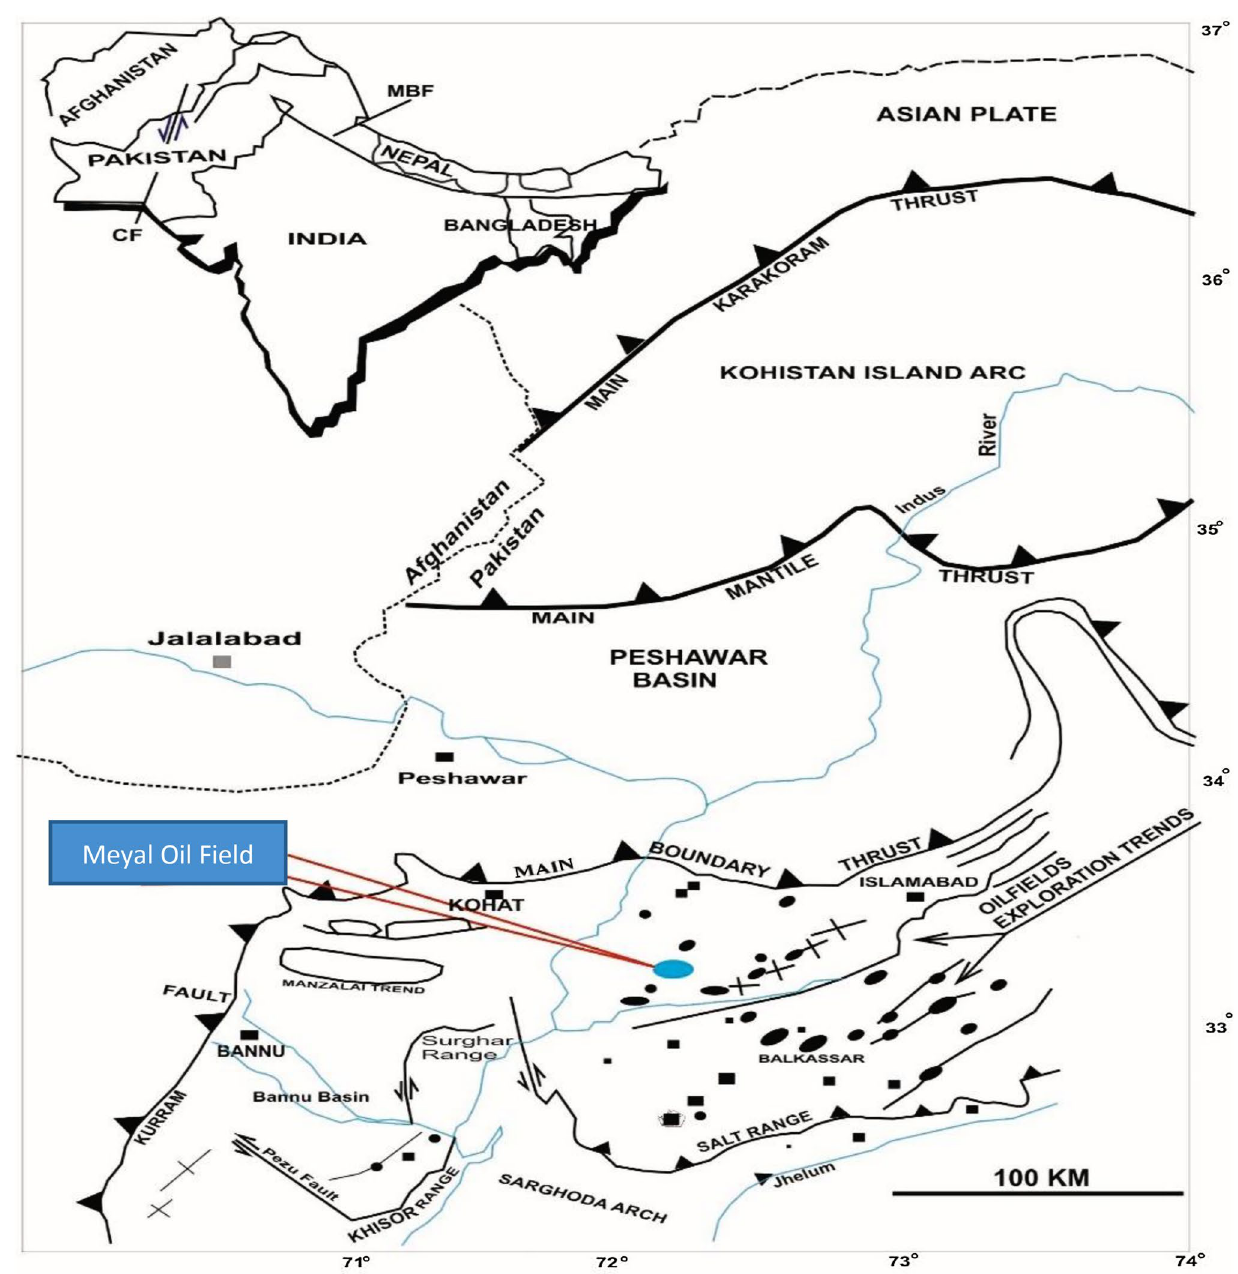
Fig. 1 Regional map showing location and tectonic setting of the Meyal Oil Field (marked by blue ellipse). Modified after Kazmi and